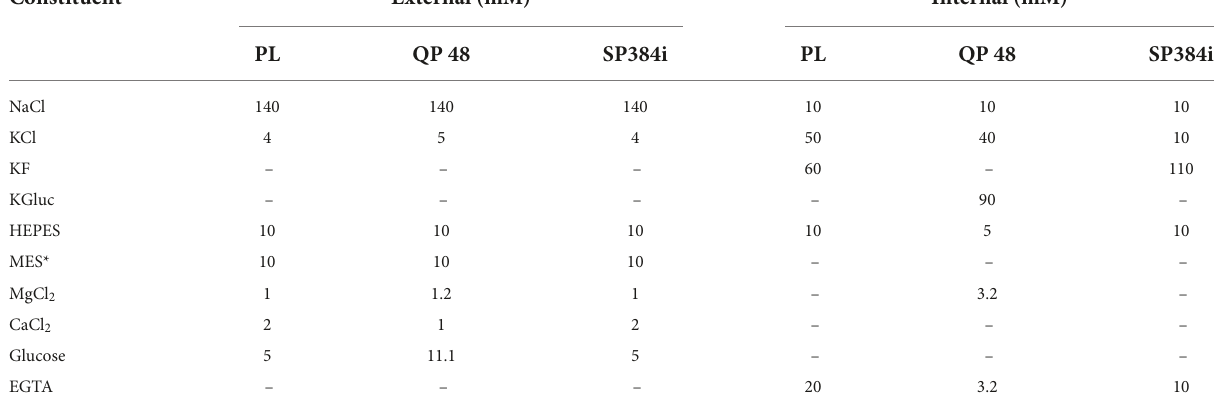
TABLE 1 APC internal and external